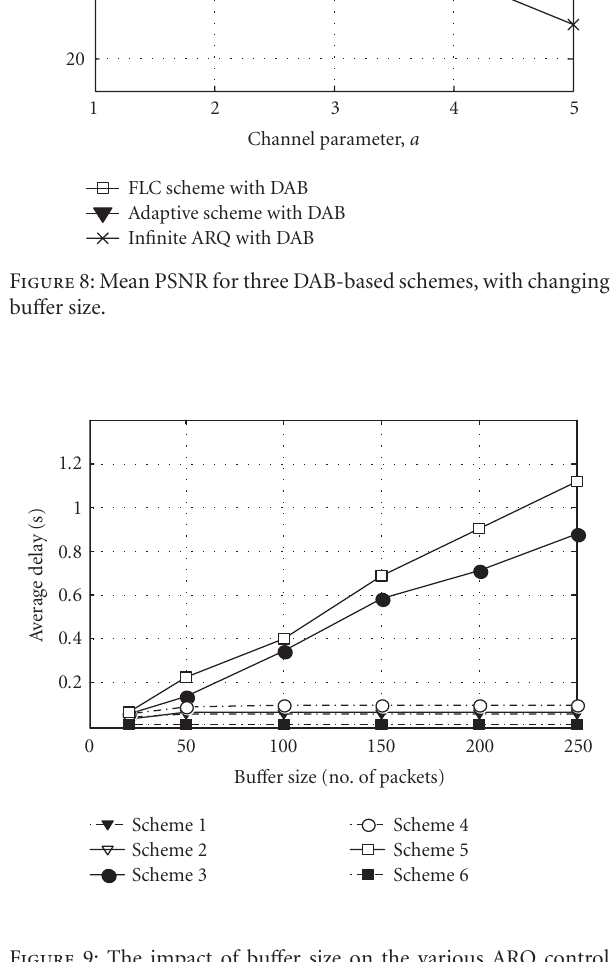
Figure 9: The impact of bu ff er size on the various ARQ control schemes in Table